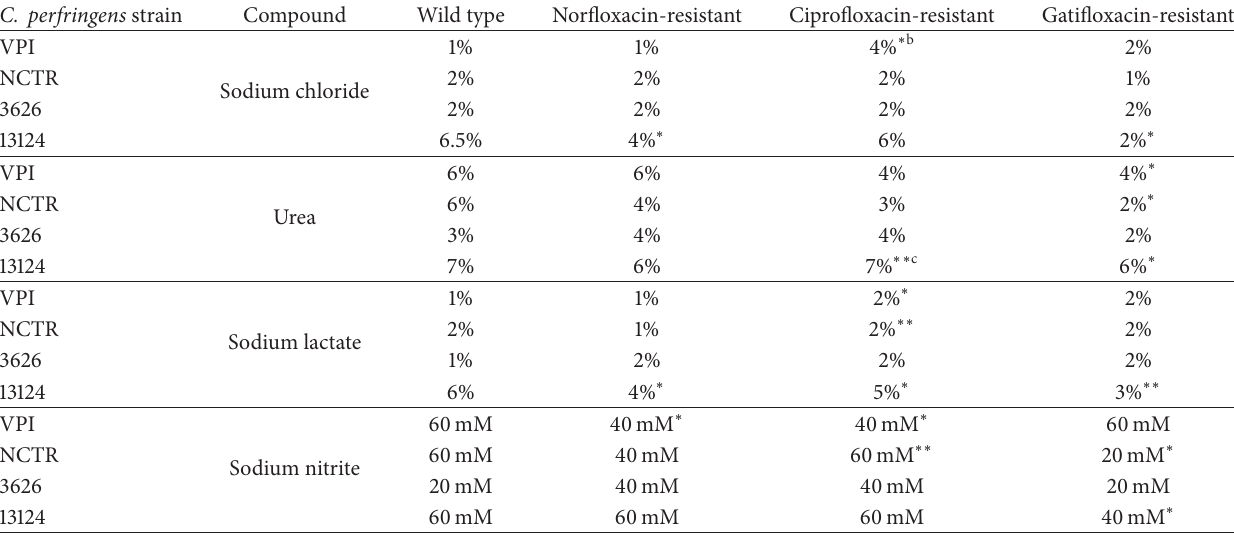
Table 2: Effect of fluoroquinolone resistance selection on the growth of C. perfringens strains (shown by OD of sodium chloride, urea, sodium lactate, and sodium nitrite a